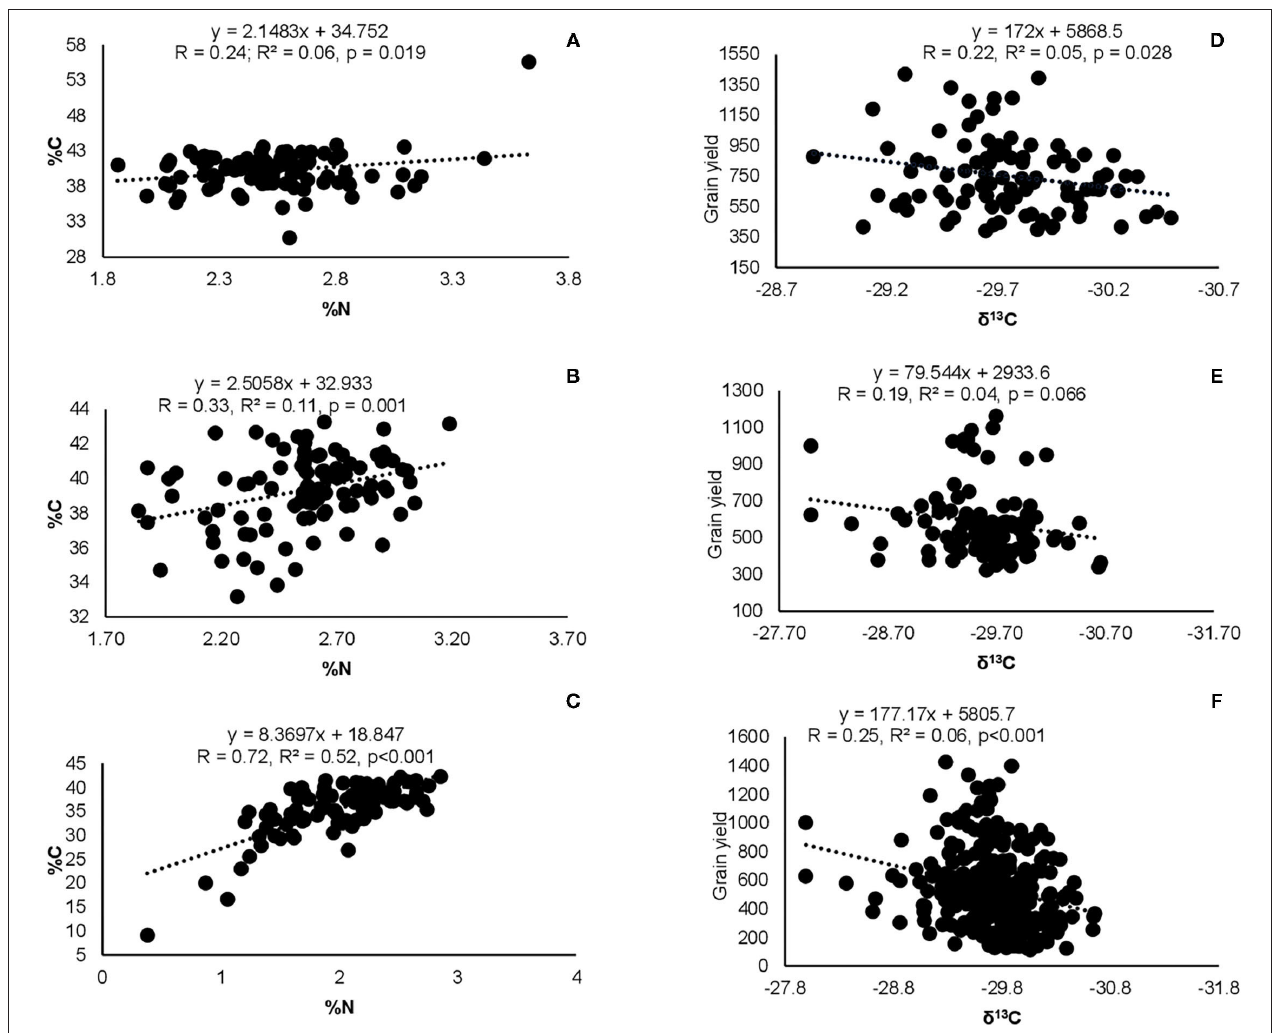
FIGURE 6 | Correlation and regression analysis between shoot %N and %C at (A) Nyankpala, (B) Savelugu, (C) Gbalahi, and between δ 13 C and grain yield at (D) Nyankpala, (E) Savelugu, as well as (F) between δ 13 C and grain yield of the combined data from the three locations.